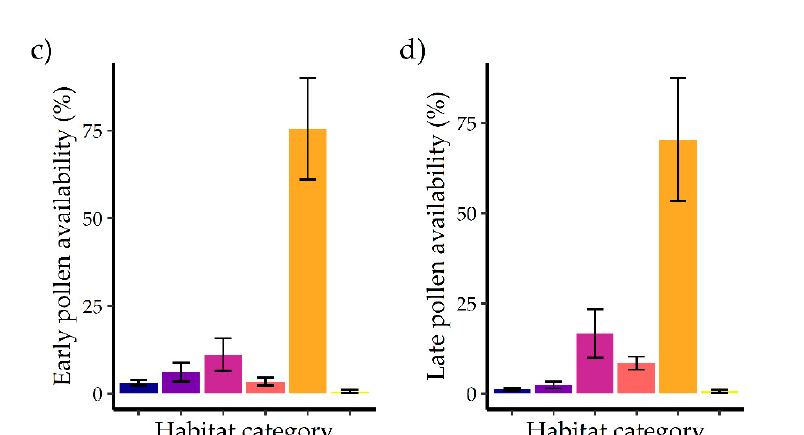
Figure 1. Average (±1 standard error) area of habitat categories (arable, permanent crops, forest edges, herbaceous semi-natural habitats, and woody semi-natural habitats but excluding forests and built- up area) in the studied landscapes ( a ), their average contribution to pollen availability per landscape ( b ), in the early season ( c ), and in the late season ( d ). Pollen availability is based on the relative area covered by plant species offering a pollen type in the respective habitat type across all landscapes multiplied by the relative collected pollen volume of each type over the whole season.